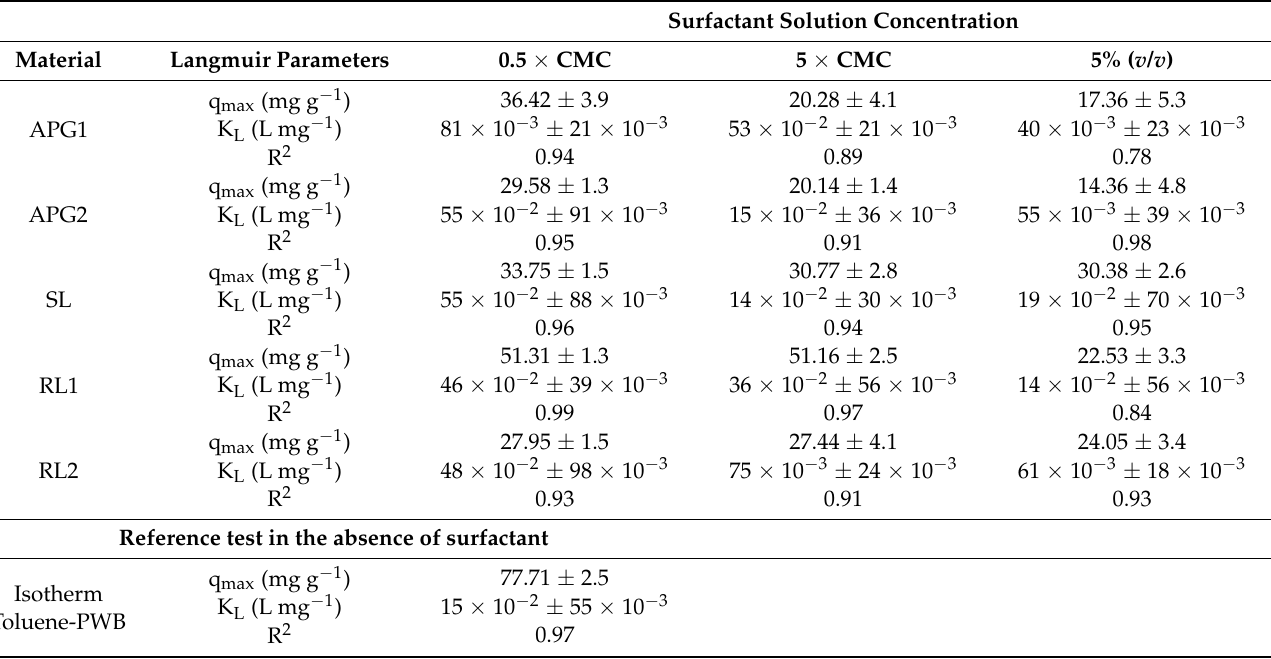
Figure 3. Isotherm curve of the adsorption of toluene on PWB in surfactant solutions at different concentrations for ( a ) APG1, ( b ) APG2, ( c ) SL, ( d ) RL1, and ( e ) RL2. Table 3. Optimized parameters of the Langmuir model of toluene on PWB in the presence and in the absence of surfactants.